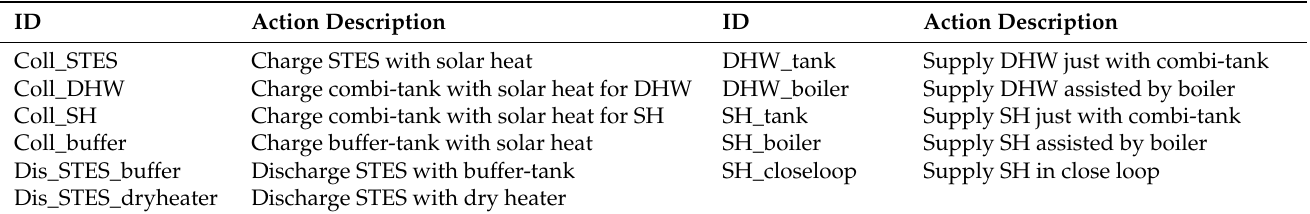
Table 3. Operational modes of the system